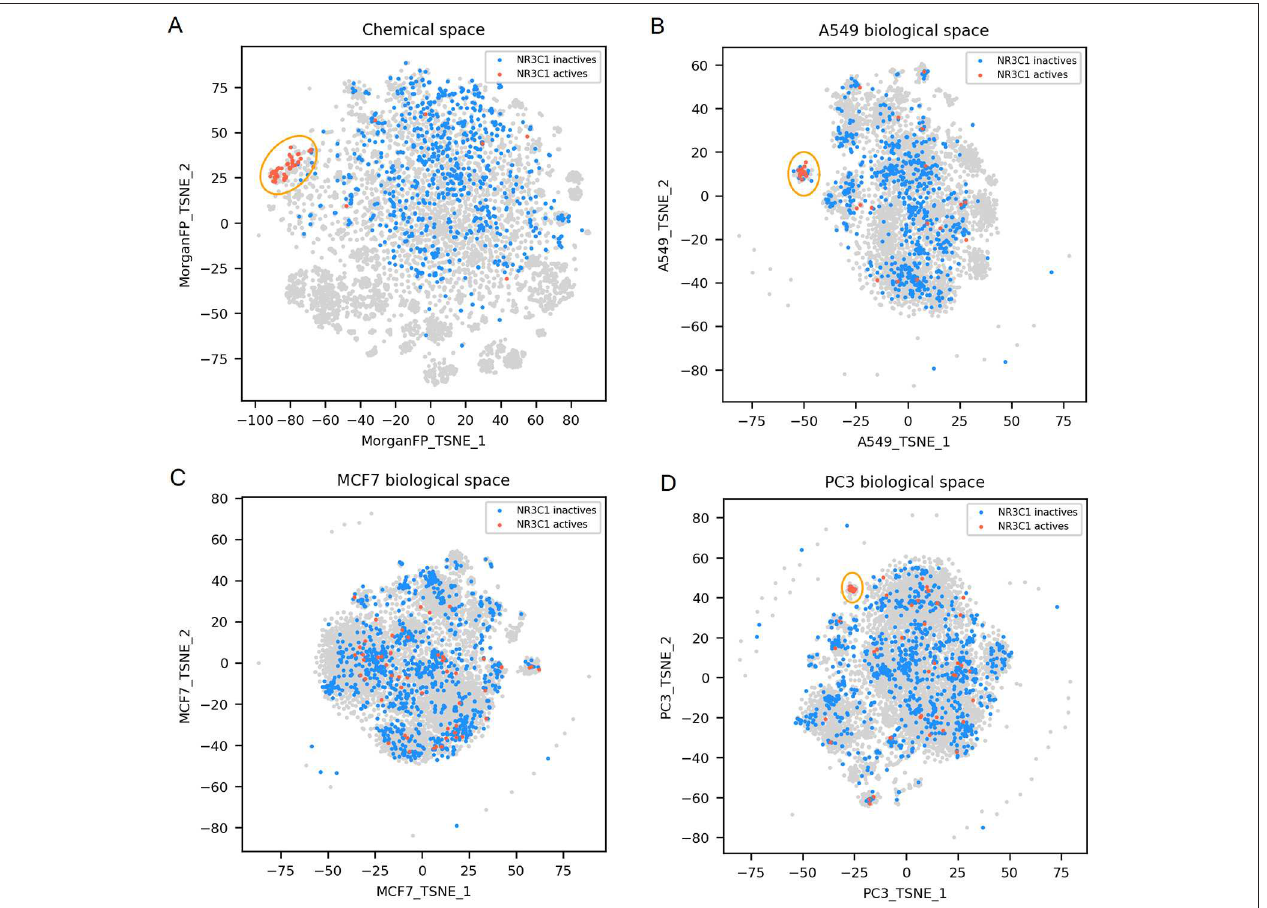
FIGURE 3 | NR3C1 active and inactives compounds in the chemical space and the different biological spaces formed by GES produced in a single cell line. (A) Chemical space; (B) t-SNE on all A549 signatures (A549 biological space); (C) t-SNE on all MCF7 signatures (MCF7 biological space); (D) t-SNE on all PC3 signatures (PC3 biological space). Points corresponding to NR3C1 actives are red ( n NR3C1 activity. Orange circles point out clustering of active